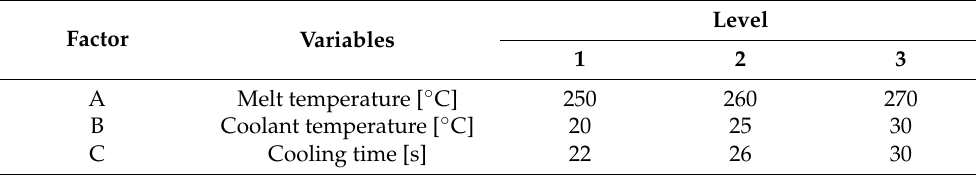
Table 8. Design variables and levels for pivot sub-assembly.